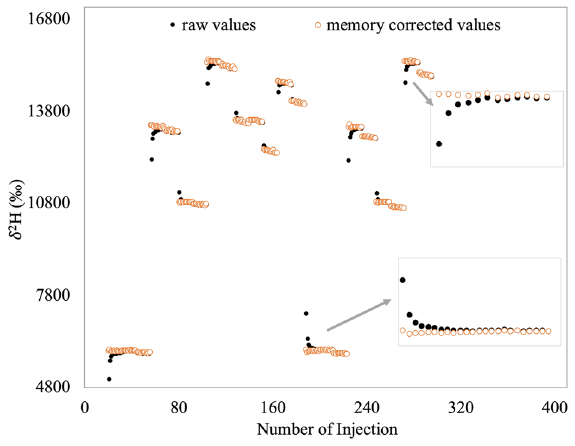
Figure 1. The memory effect of δ 2 H observed in an initial samples’ measurement batch. The measured (raw) values are showed by the black circles and the open red circles indicate the values after memory effect correction by the 3 pools exchange algorithm. In addition to the memory, there is also some drift visible which is also corrected by the data analysis